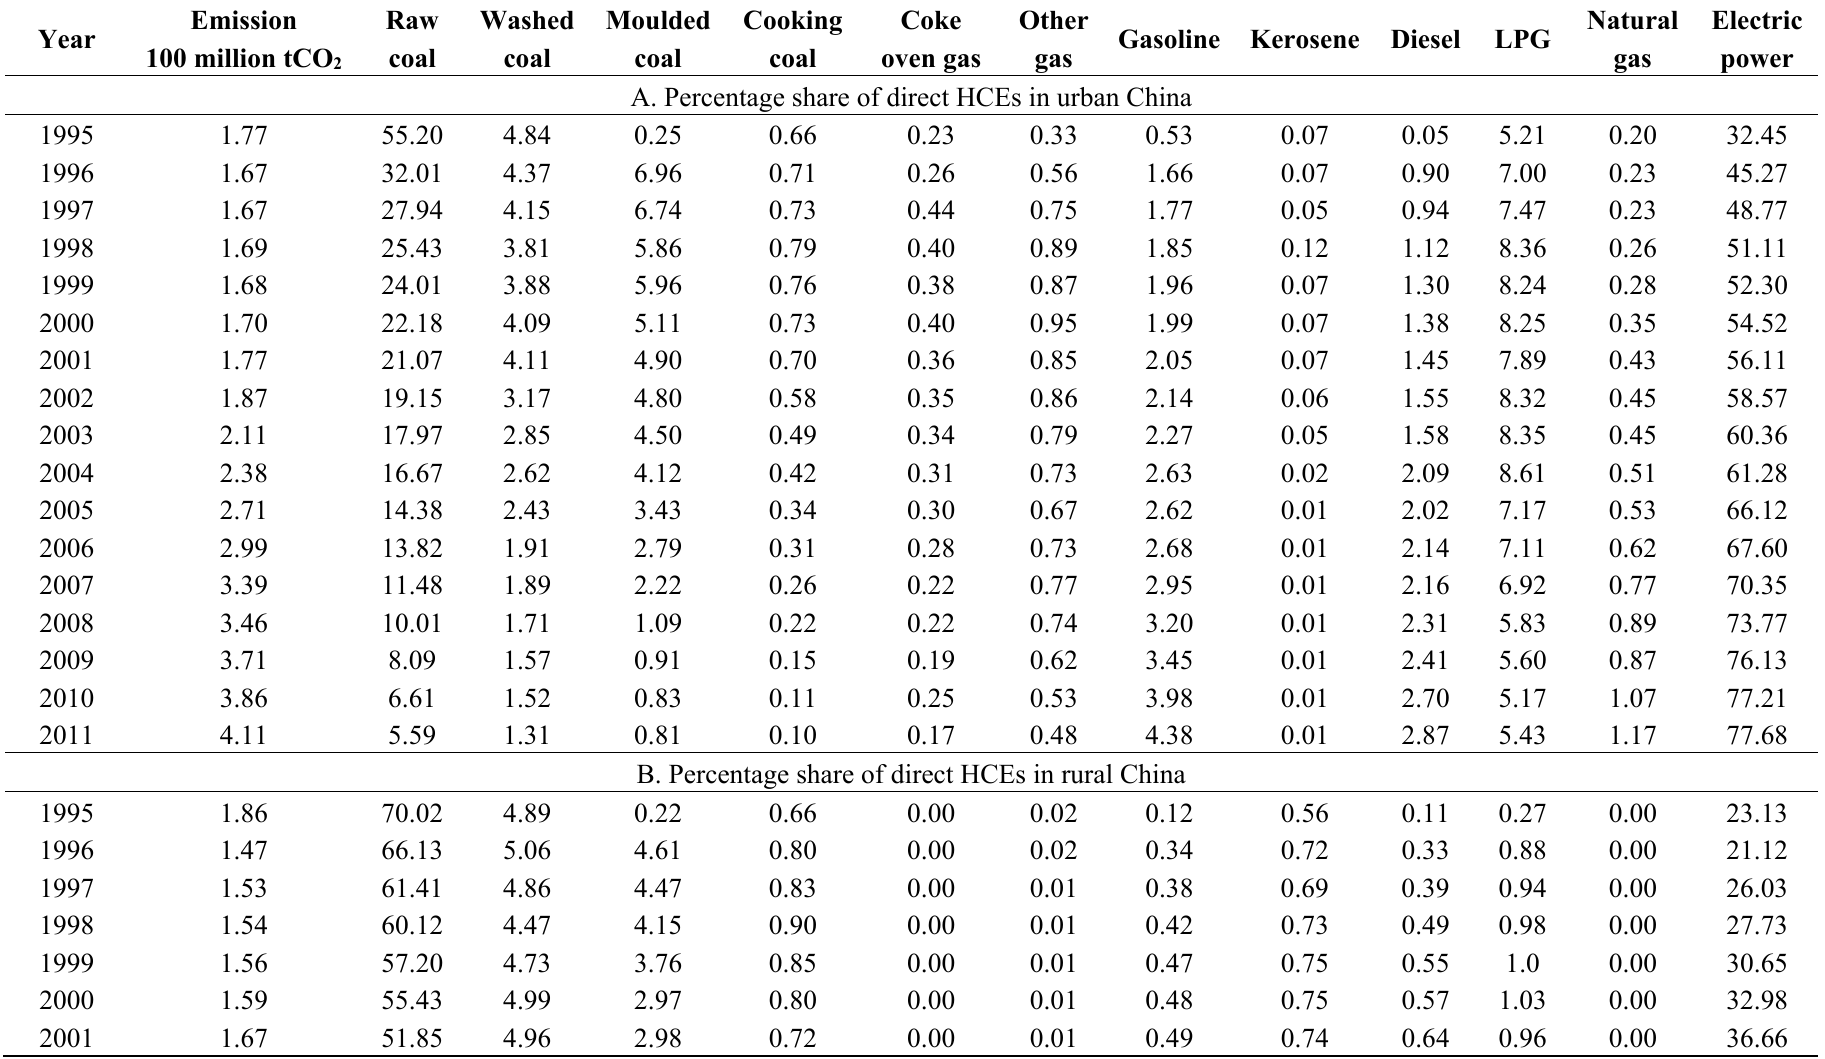
Table 3. Percentage share of household carbon emission (HCEs) by different direct sources in rural and urban China, 1995–2011 (values in parentheses indicate decrease in percentage